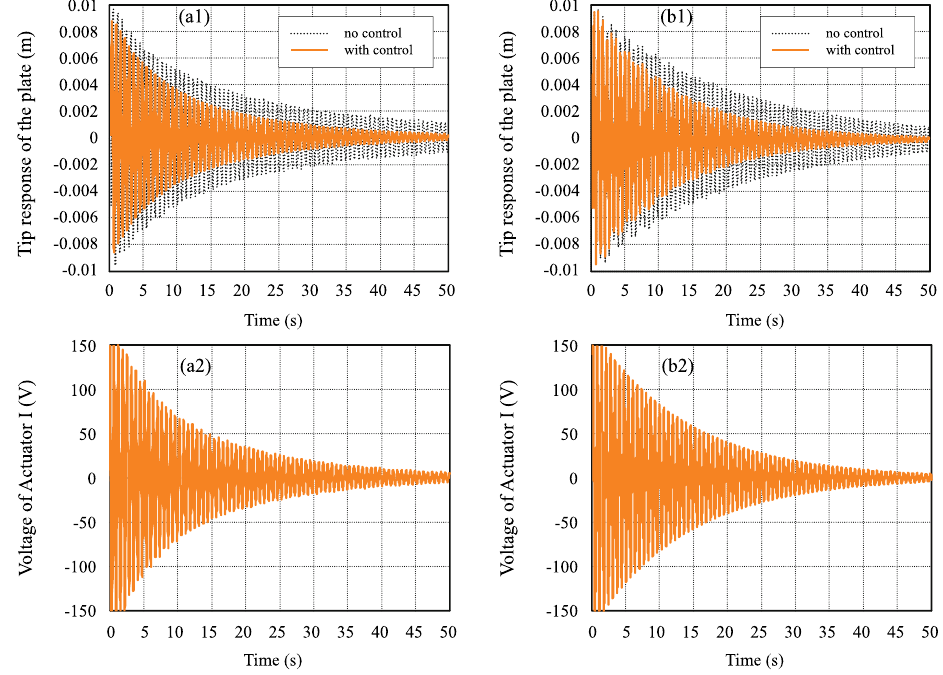
Fig. 5. Response of the plate and applied voltage of Actuator I when K = [1 . 4542 , 35 . 0246] is used for the plate with time delay τ = 0 . 06s (one actuator case): (a) experimental result and (b) simulation